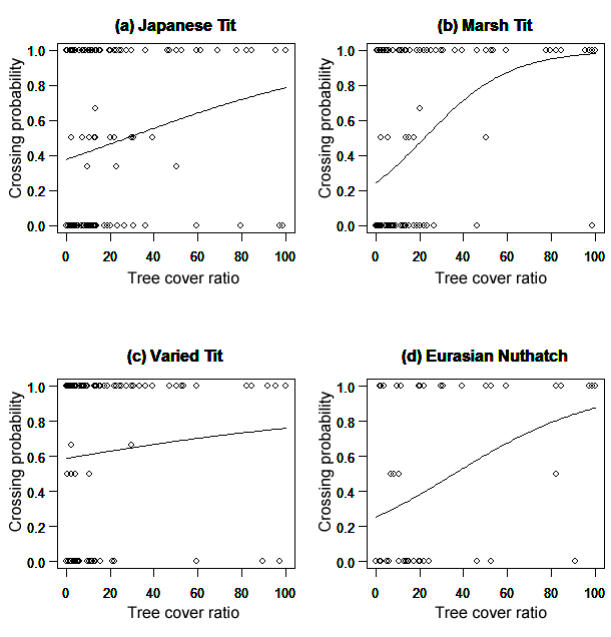
estimated to be the highest in the breeding season among the three seasons for Varied Tit (Table 2). The building area and electric wire density were not associated with the crossing probability of any of the focal species, and the RVI (Relative Variable Importance) of these variables was mostly low. The crossing probabilities of three focal species other than Varied Tit were significantly positively associated with the tree cover (Fig. 2; Table 2). When the interaction between the tree cover and season was added as a variable in the averaged model for focal species, no significant interaction terms were detected (Appendix 3). Fig. 2 . Relationship between the ratio of tree cover and crossing probability of four focal species. The continuous variable other than the tree cover were set to average and the season was set to dispersal